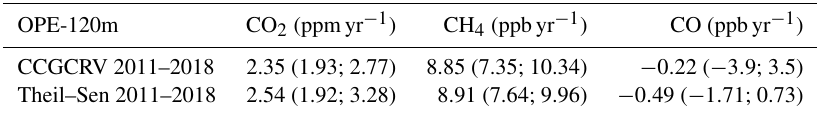
Figure 11. Mean seasonal cycles of the afternoon data at the three measurement levels (10m in red, 50m in green and 120m in blue) for CO 2 (a) , CH 4 (b) and CO (c) computed over the 2011–2018 period using CCGCRV. Table 7. Growth rates of CO 2 , CH 4 and CO mole fractions at OPE 120m level for the period 2011–2018 computed on the afternoon mean data using the CCGCRV and Theil–Sen methods. The 95% confidence intervals are displayed for each compound and